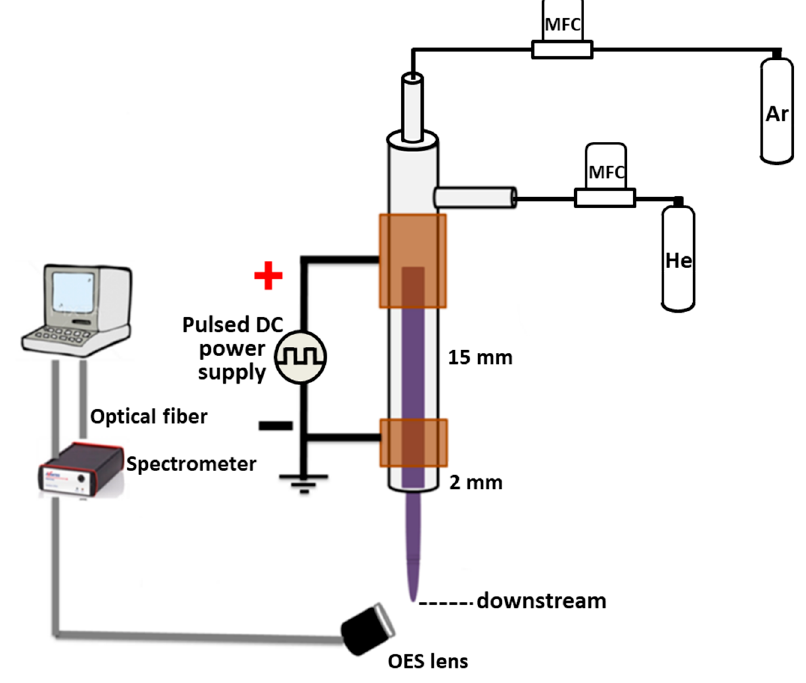
Figure 1. The setup of a cold atmospheric plasma jet (CAPJ). Table 1. Factors and levels of CAPJ parameters for the antimicrobial of E.